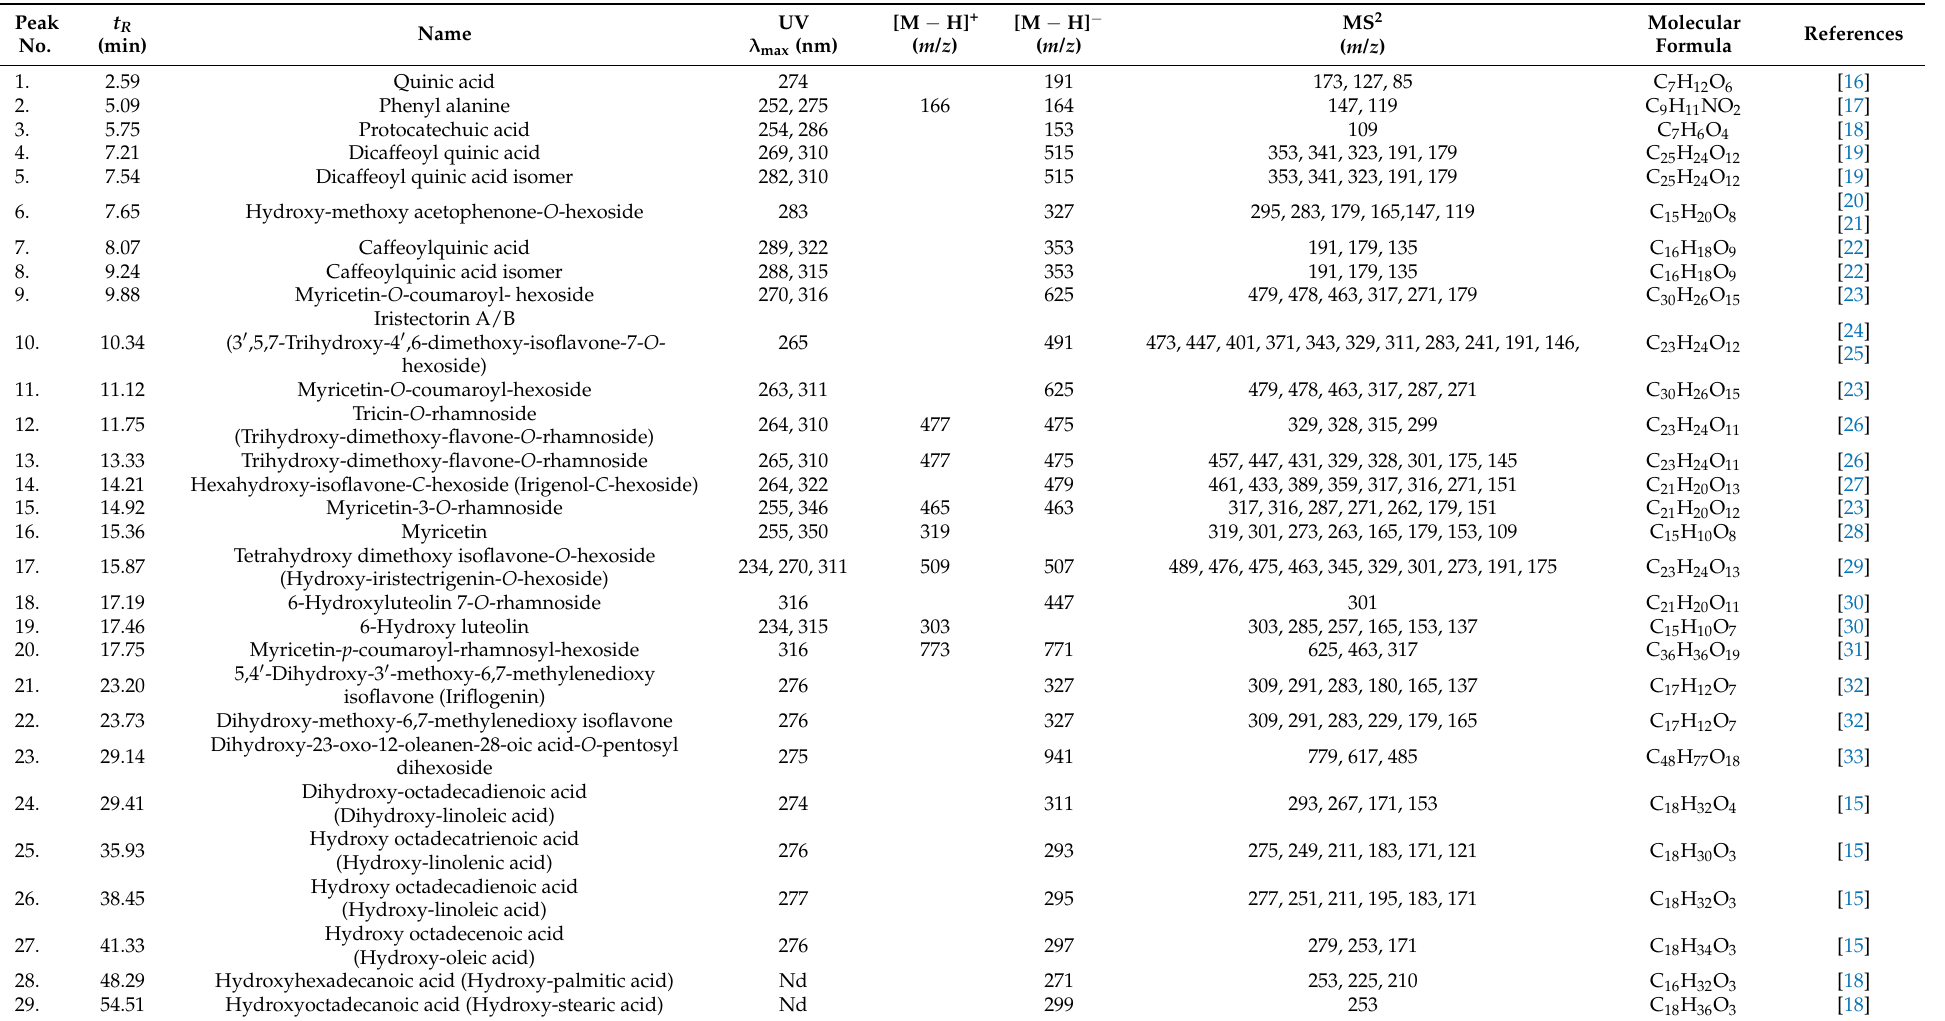
Table 2. Metabolite profiling of C. aethiopica leaf total methanol extract via HPLC-PDA-ESI-MS/MS in the positive and negative ion mode. Peak